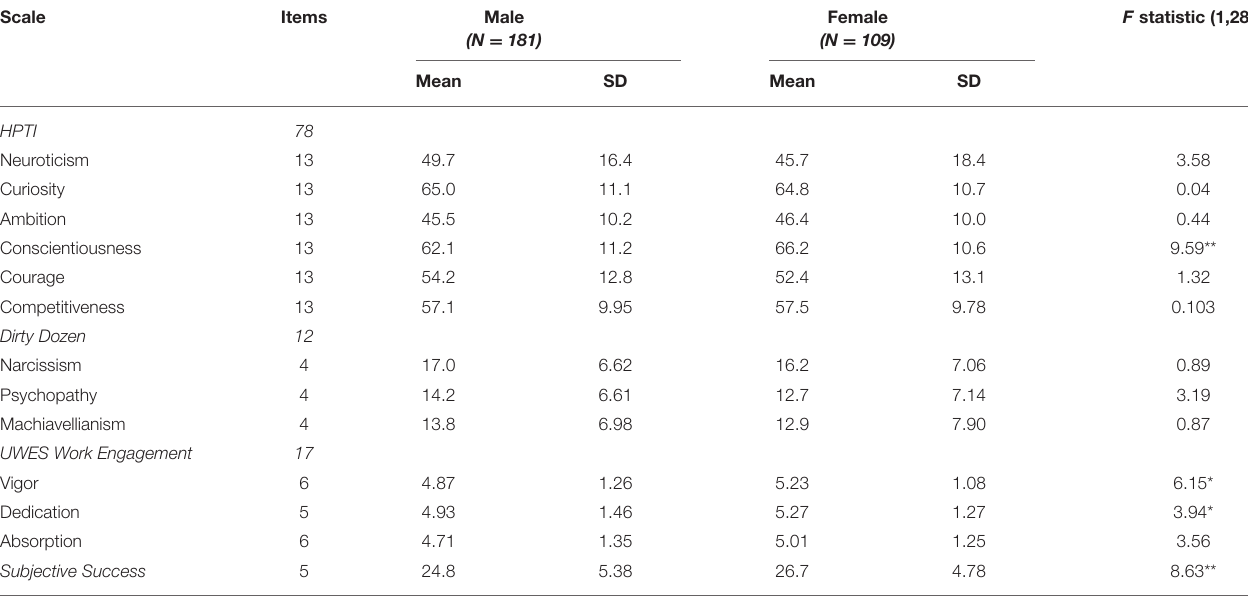
TABLE 1 | Sex differences in the HPTI, Dirty Dozen, UWES, and Subjective Success subscales. Scale